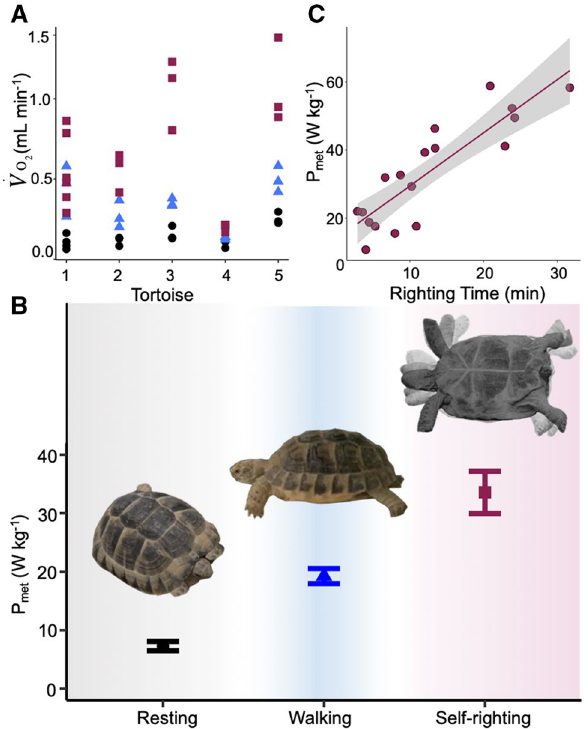
˙ V O 2 , mL min −1 ) and ( B )